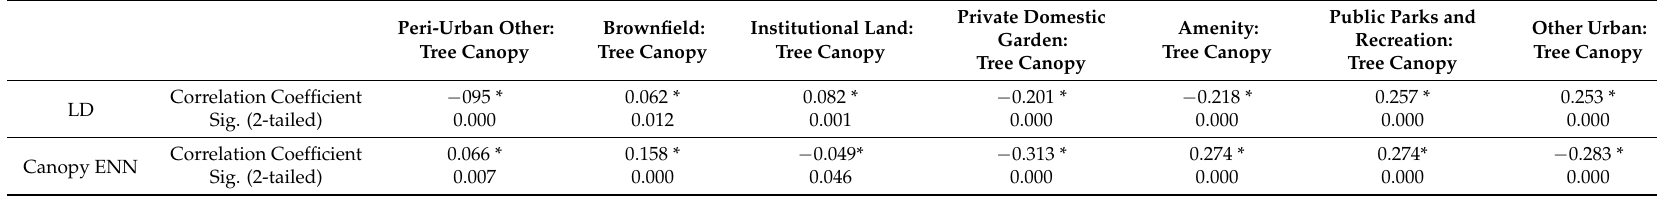
Table 3. Correlation matrix: selected ILM landscape features with landscape division and canopy connectivity (Euclidean nearest neighbour) * denotes p <